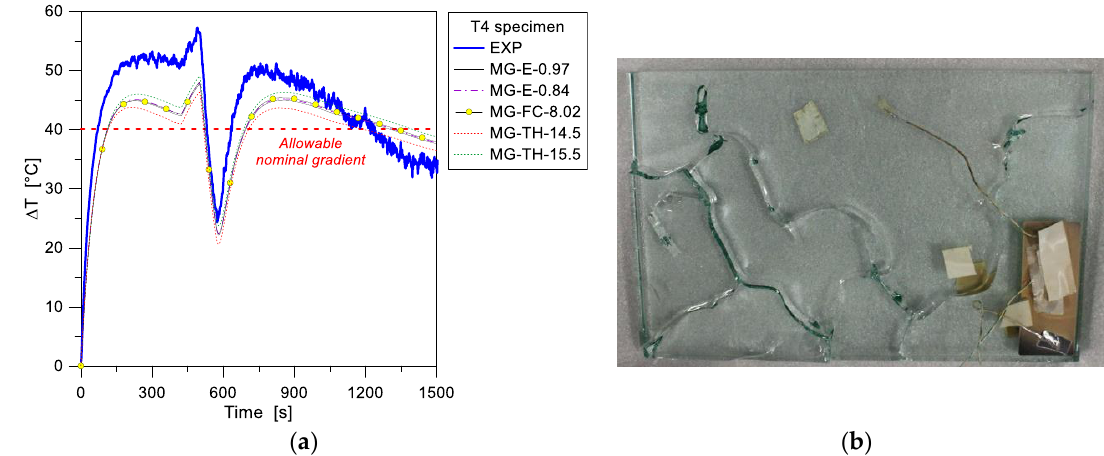
Figure 8. ( a ) Temperature gradient comparisons for the MG specimen T4, as obtained from the FE parametric analyses (ABAQUS, 1D) and the past experimental test, with ( b ) experimental crack pattern at the end of the test (reproduced from [14] with permission from Elsevier, Copyright license n. 4404210422661, August 2018).